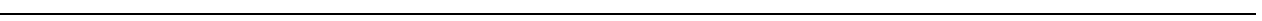
Fig. 5 Identi fi cation of kinases responsible for tau phosphorylation. a In vitro phosphorylation assay with GST-tau and GST-kinase expressed in baculovirus. Autoradiography indicated that GST-tau was phosphorylated by all the kinases and labeled with γ - 32 P-ATP during the phosphorylation reaction. Speci fi c antibodies against mouse Ser203/human Ser214 or mouse Thr220/human Thr231 detected the kinases responsible for phosphorylation at each site. Results for GST-human tau (wild type), GST-human tau S214A mutant, and GST-human tau Thr231Ala mutant are shown in the upper, middle, and lower panels. Human tau Ser214 and Thr231 correspond to mouse Ser203 and Thr220, respectively. Thus, the middle and lower panels show negative controls. b In vivo assay of COS7 cells expressing GFP-tau and kinases tagged with GST or HA. Expression levels of tau proteins and kinases were con fi rmed with anti- GFP or anti-GST/HA antibody, respectively. Western blots with speci fi c antibodies against mouse Ser203/human Ser214 or mouse Thr220/human Thr231 revealed that all kinases could phosphorylate tau at each site. Results for EGFP-human tau (wild type), EGFP-human Ser214Ala mutant, and EGFP-human tau Thr231Ala mutant are shown in the upper, middle, and lower